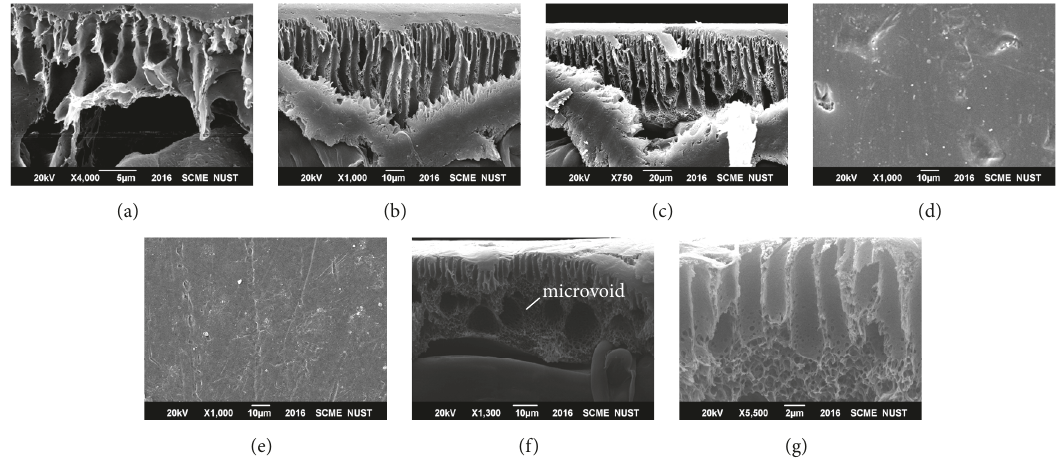
Figure 3: SEM Images. (a) M1 cross-sectional, (b) M2, (c) M3 cross-sectional, (d) M1 Surface, (e) M3 Surface, (f) MS-1, and (g)